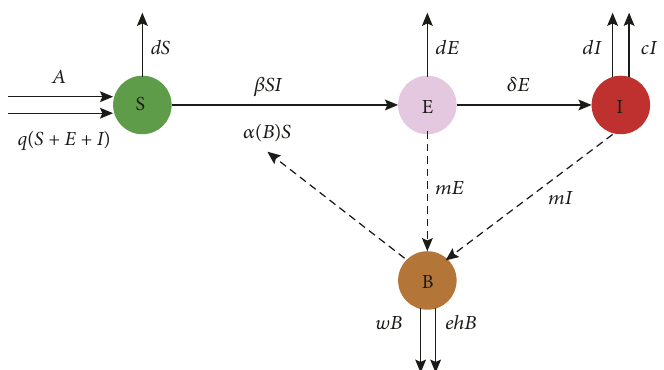
Figure 1: A flow diagram of brucellosis transmission.